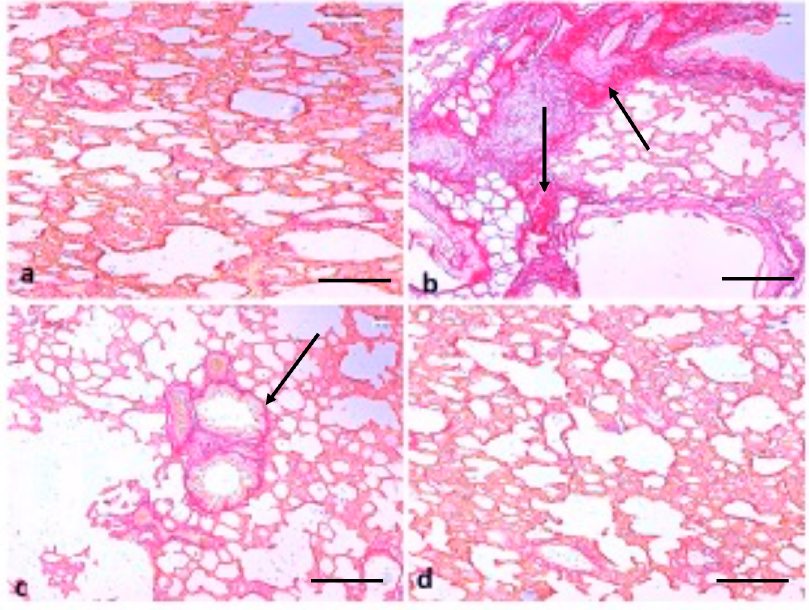
Figure 8. Effect of TQ on lung fibrosis. ( a ) Normal fibre architecture of lung in control animals; ( b ) B(a)P administration induces severe fiber deposition; the arrow indicates deposition of fibers ( c ) TQ shows suppression of B(a)P-induced fibrosis, the arrow indicates less deposition of fibers and ( d ) normal fibre architecture observed in the group treated with TQ only. (Scale bar = 100 μ m.)